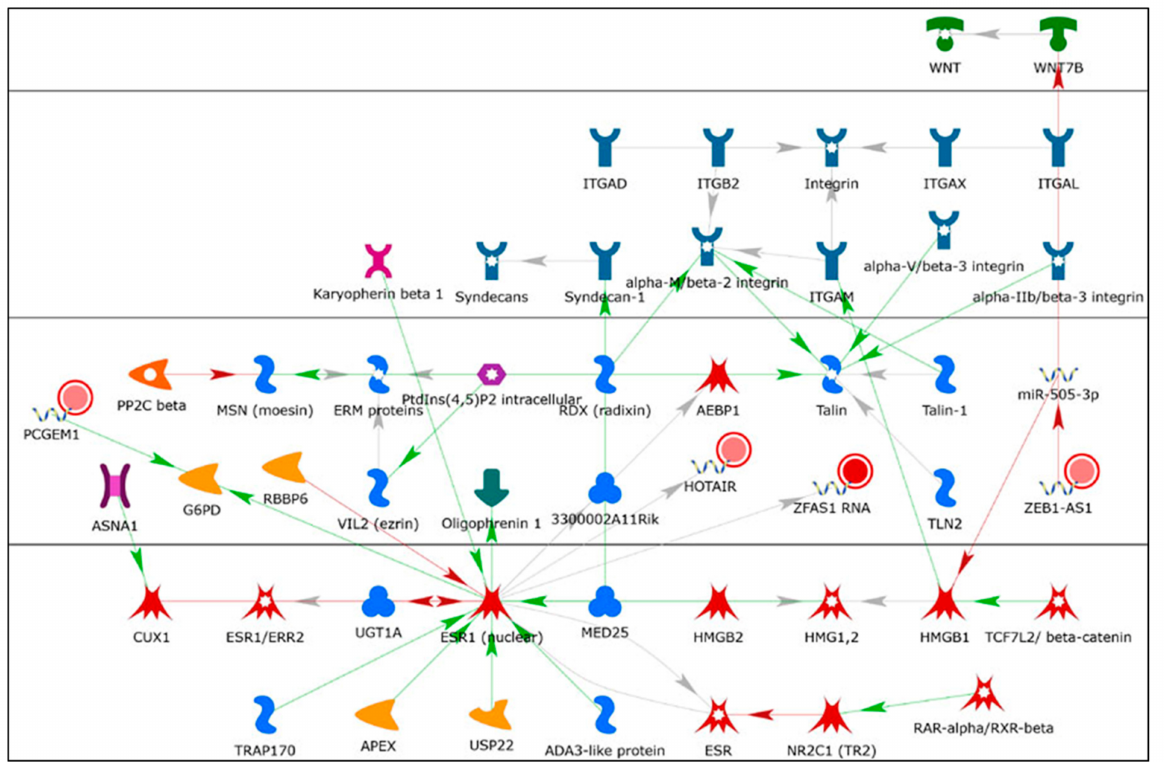
Figure 11. Network 3: PCGEM1, ZFAS1 RNA, ZEB1-AS1, HOTAIR, and ESR1 , identified in lncRNAs differentially expressed in MCF-7 and or LCC9 cells by MetaCore analysis. Green lines with arrows = stimulation; red lines with arrows = inhibition.